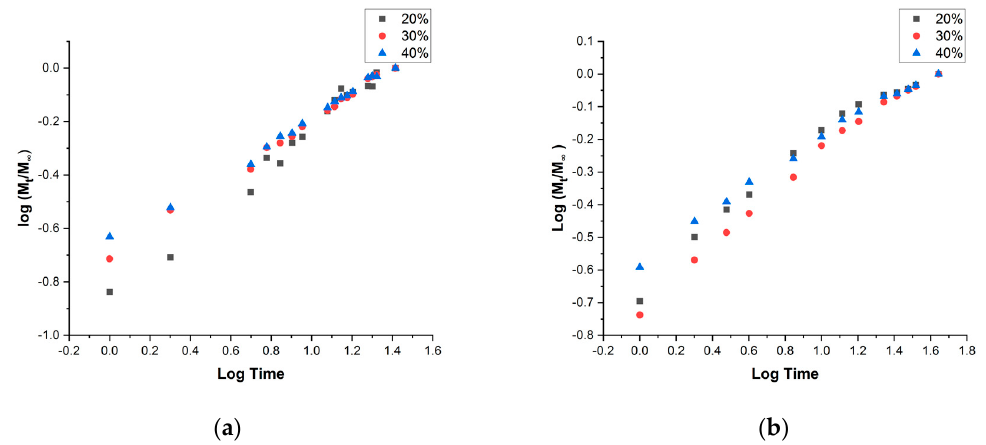
Figure 6. Kinetic study of PP composites reinforced with hemp strands under ( a ) immersion condi- tions and ( b ) at 50% RH.